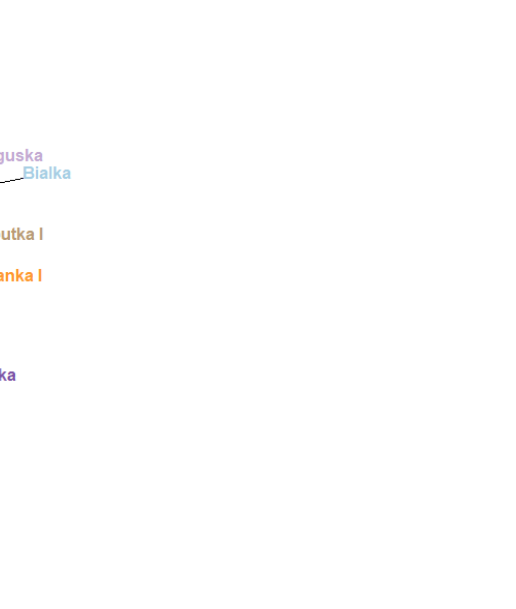
Figure 3. Population structure of 16 dam lines–unrooted Nei tree based in the Fst distant matrix. The average allelic richness estimated for each locus for all samples was 7.635. Allelic richness per locus (<5.000) was the lowest at loci HTG6 (4.956) and HTG7 (4.978), and the highest (>8.000) were at ASB2, HTG10, VHL20, ASB17, and ASB23 (from 8.983 to 10.989). The allele’s mean number for the whole group studied was 7.647 ( ± 0.411), while the effective allele’s mean number was 4.471 ( ± 0.286).